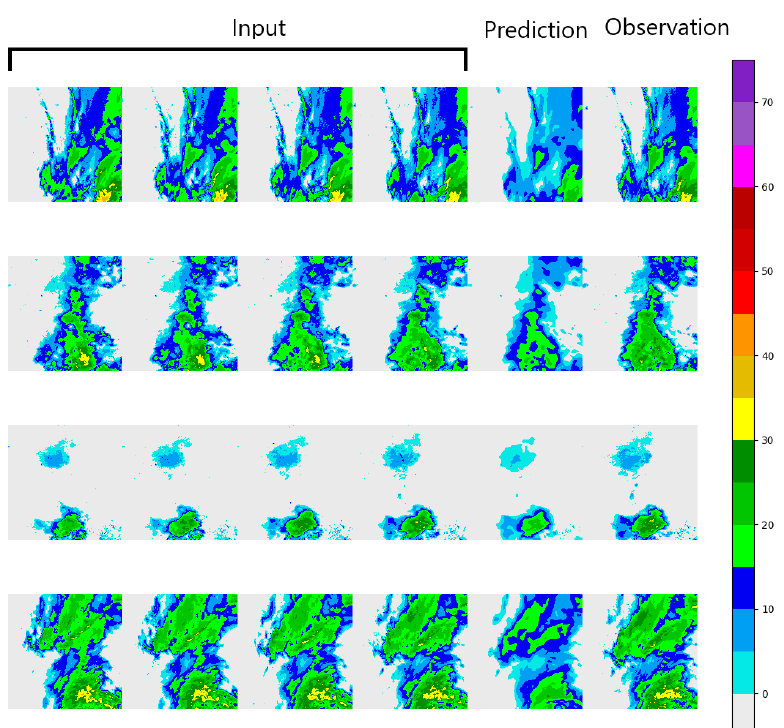
Figure 10. Sample predictions from our model that was trained using the MET dataset for a 5-min lead time. The first four columns show the inputs, the fifth column depicts the predictions and the last column shows the observations. The illustrated observations and predictions correspond to radar measurements that were gathered in an area of approximately 250 × 250 km.